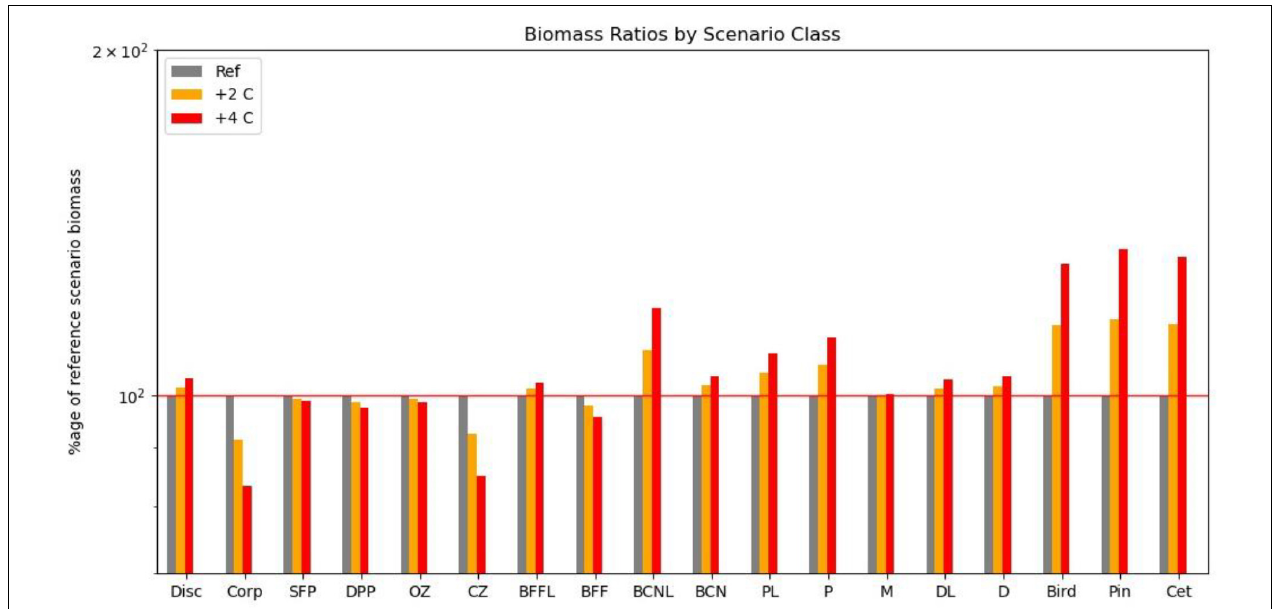
FIGURE 5 | Impact on functional groups across all fishing scenarios for the reference climate, and for warming of 2 and 4 centigrade if omnivorous zooplankton metabolic demand is decreased by 25%. Disc, discards; Corp, corpses; SFP, surface phytoplankton; DPP, deep phytoplankton; OZ, omnivorous zooplankton; CZ, carnivorous zooplankton; P, pelagic fish; PL, pelagic larvae; D, demersal fish; DL, demersal larvae; BFFL, benthic filter feeder larvae; BFF, benthic filter feeders; BCNL, benthic carnivore larvae; BCN, benthic carnivores; Bird, birds; Pin, pinnipeds; Cet, cetaceans.